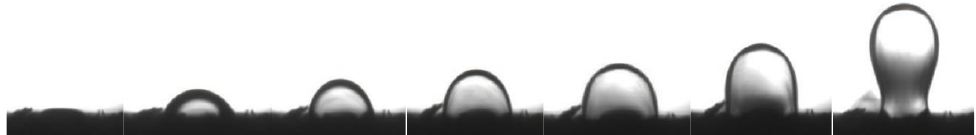
Figure 4. Morphological changes of discharged oil drop on the upper surface of tight core chip during dynamic imbibition.